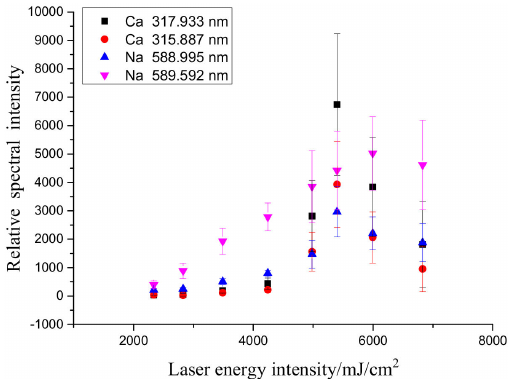
Figure 5. E ff ects of laser energy on the spectral intensities of the elements tested